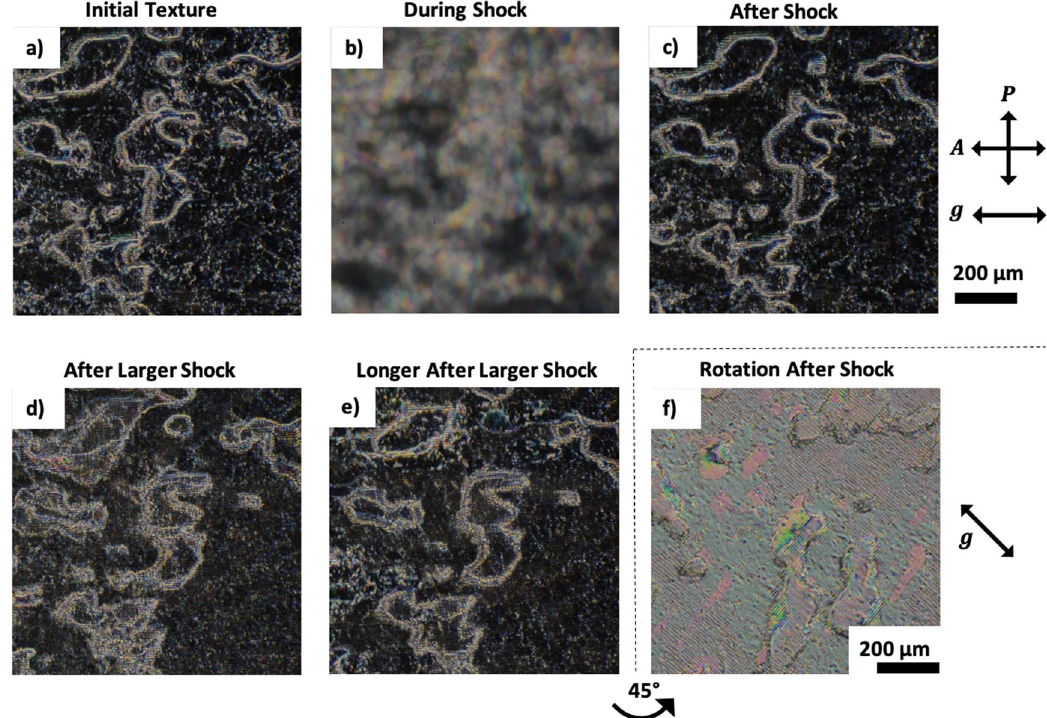
Fig. 6 Self-healing of the VGA-FLC. a – f Shock-induced fl ow of VGA-FLC Device 1 (Table 1) at T = 20 °C. a The dark texture observed with polarising optical microscopy, where g is aligned with the polarisers. b The application of a low-pressure shock induces fl ow to the LC in the device. c The alignment of the bulk is unaffected by the application of a small pressure (4.0 ± 0.7 N). d A large shock (18±1 N) induces small A 12 undulations into the texture, which can only be observed as a slight increase in transmission due to a double-undulating texture b e ing induced. e The texture 30 min after the initial shock remains almost unchanged, but some dissipation of the double-undulating texture has occurred. f 45° rotation of the device reveals the metastable texture of the undulations induced by shock-induced fl ow, which highlight undulations induced perpendicular to g . Importantly, the c -director is still well aligned after shock-induced fl ow. Table 1 Physical properties of three VGA-FLC